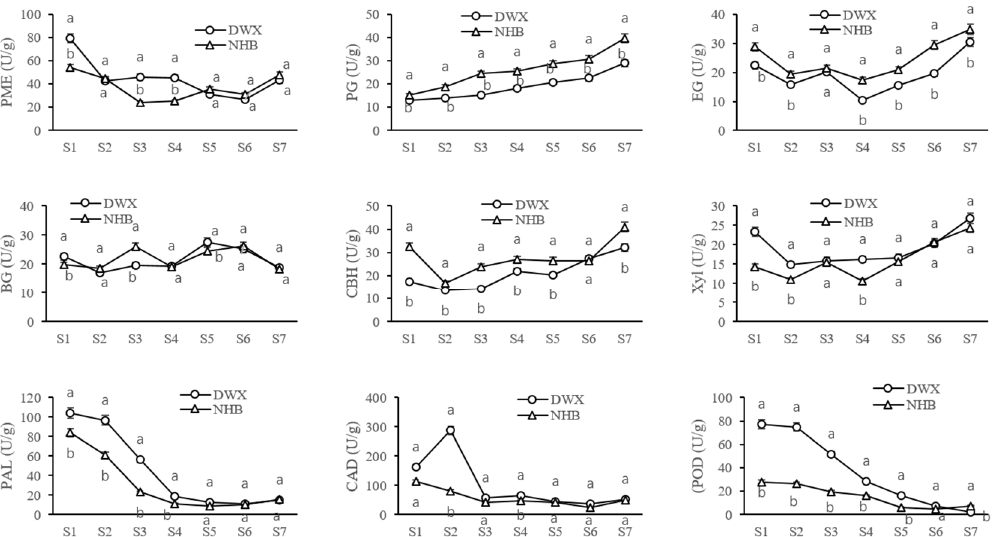
Figure 2. Dynamic changes of water-soluble pectin (WSP), ionic-soluble pectin (ISP), covalent-soluble pectin (CSP), cellulose, hemicellulose, and lignin contents at seven different stages during loquat fruit development and ripening. The stages numbered on the x -axis correspond to those presented in Figure 1. Values are means ± SD of three biological replicates. Variance analysis was carried out independently for each of the seven developmental stages studied. The different lowercase letters in the line charts indicate significant differences ( p < 0.05).